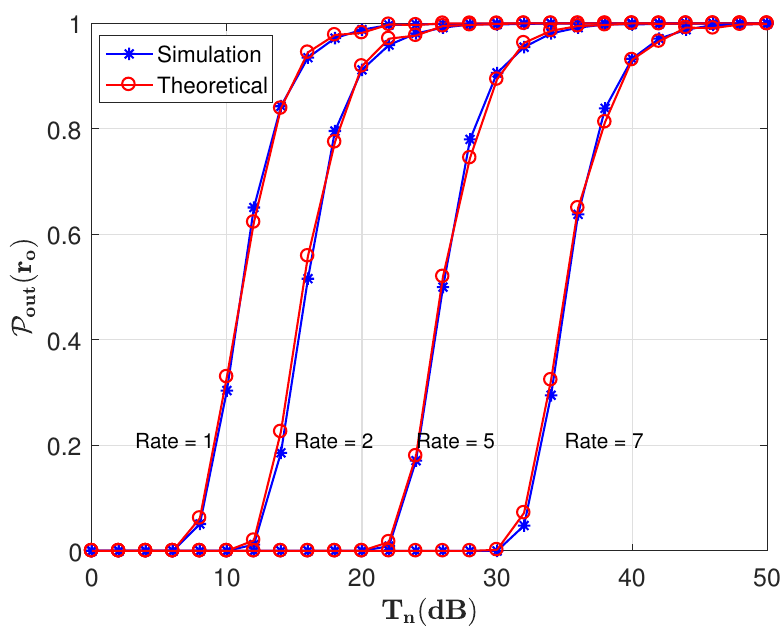
Figure 7. Outage probability with QoS target, comparing different Rate